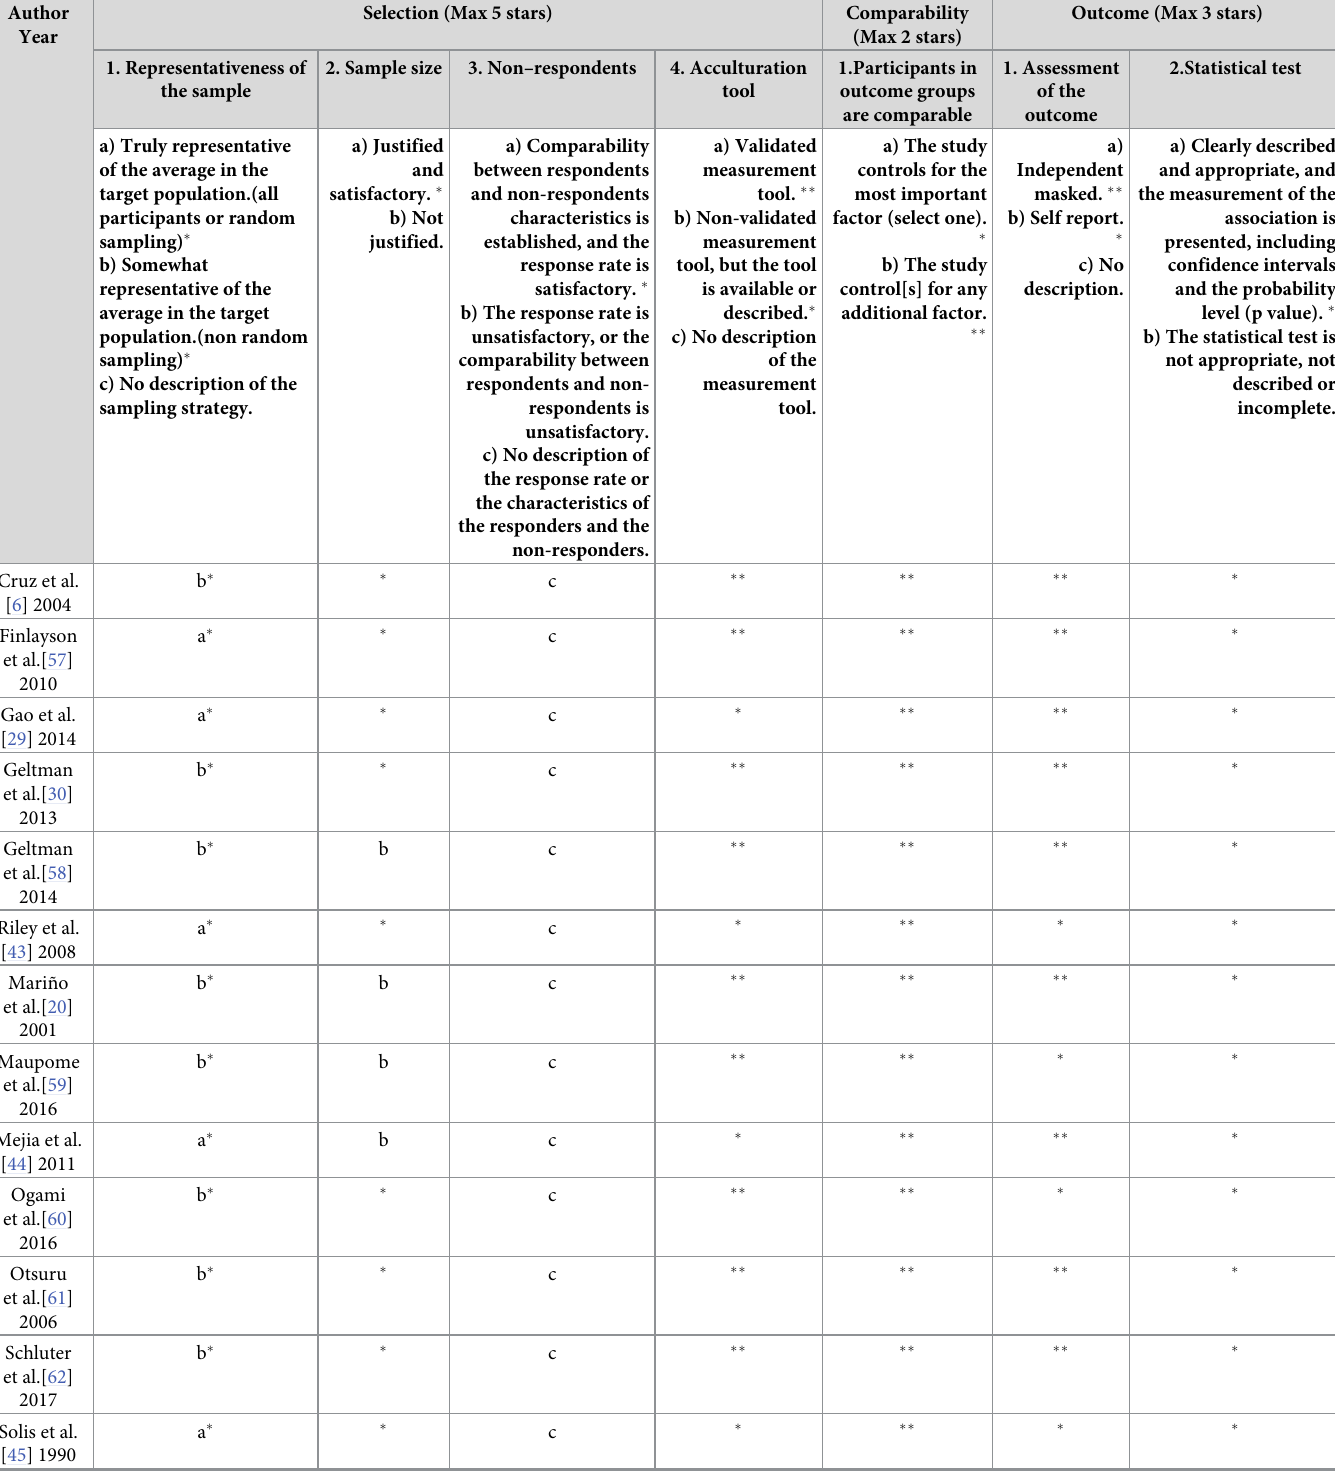
Table 2. Critical appraisal for quantitative